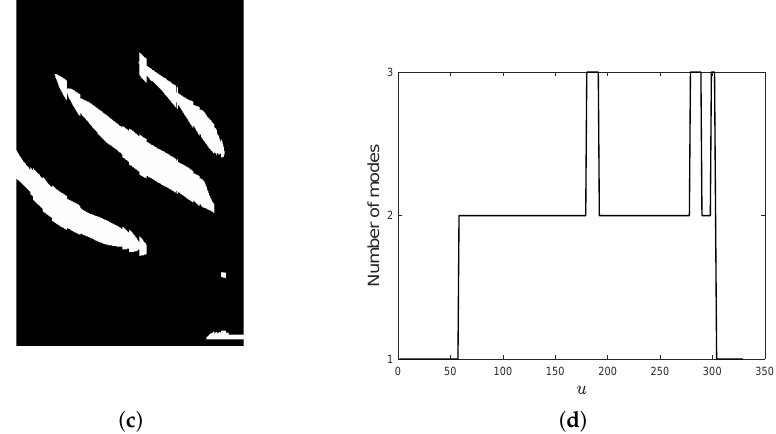
Figure 24. ( a ) Bat signal. ( b ) Spectrogram of ( a ), s = 64. ( c ) Binary map derived from ( b ). ( d ) Estimated number of